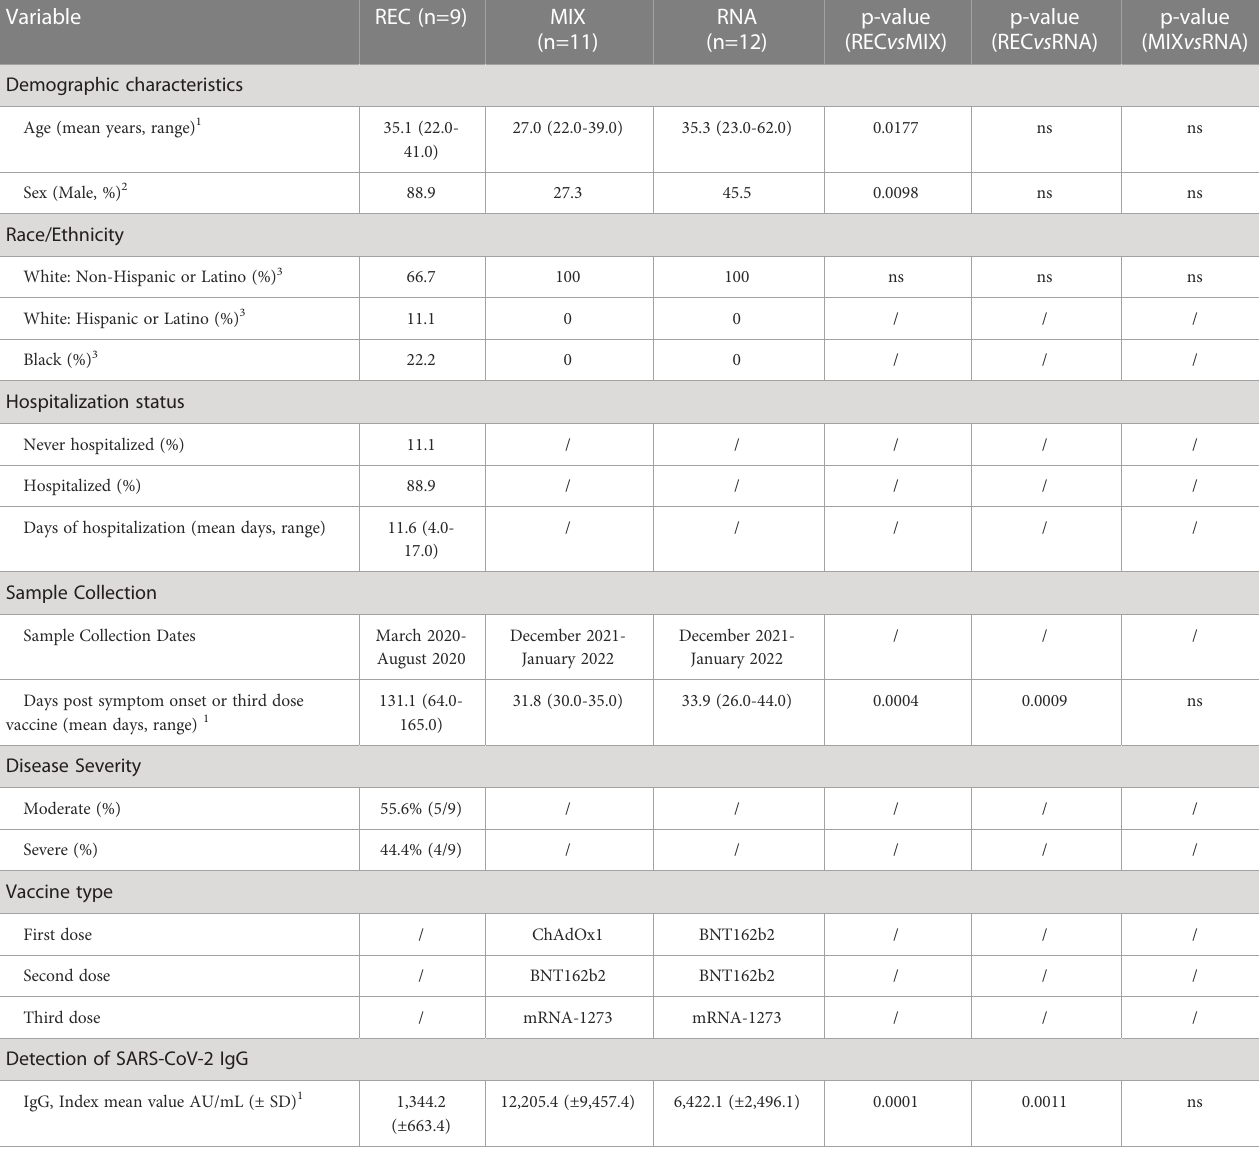
TABLE 1 Demographic and clinical characteristics of COVID-19 recovered patients and vaccinated